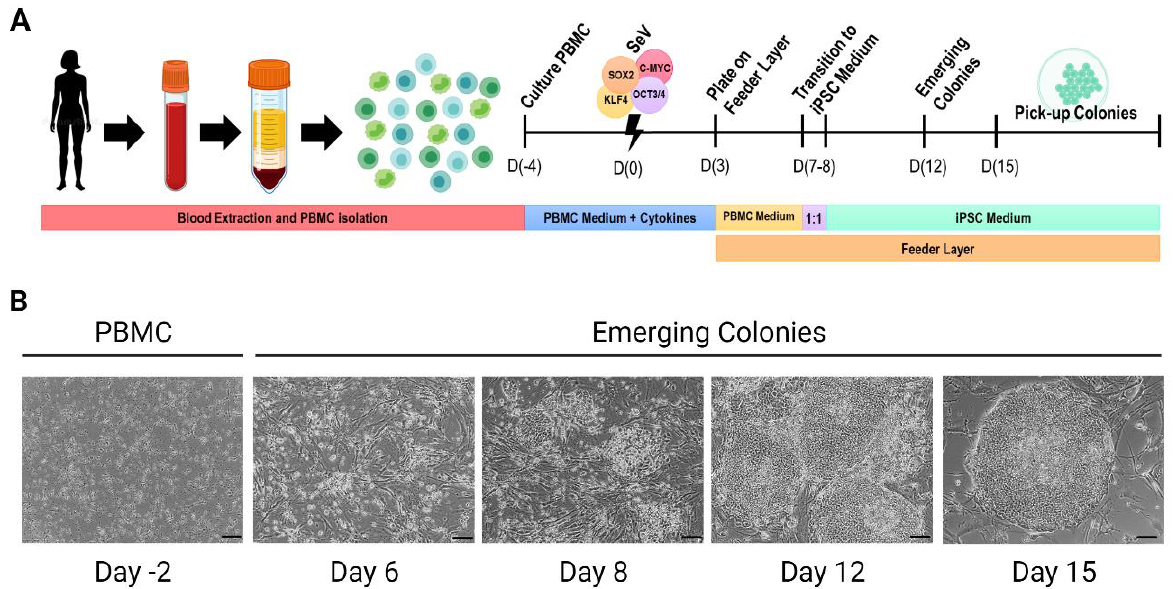
Figure 1. Cell reprogramming of human PBMC. ( A ). Generation of hiPSC lines by SeV cell repro- gramming technology. ( B ). Images of cell reprogramming procedure. Scale bar = 100 µ m. (Created with BioRender.com, accessed on 1 December 2022).